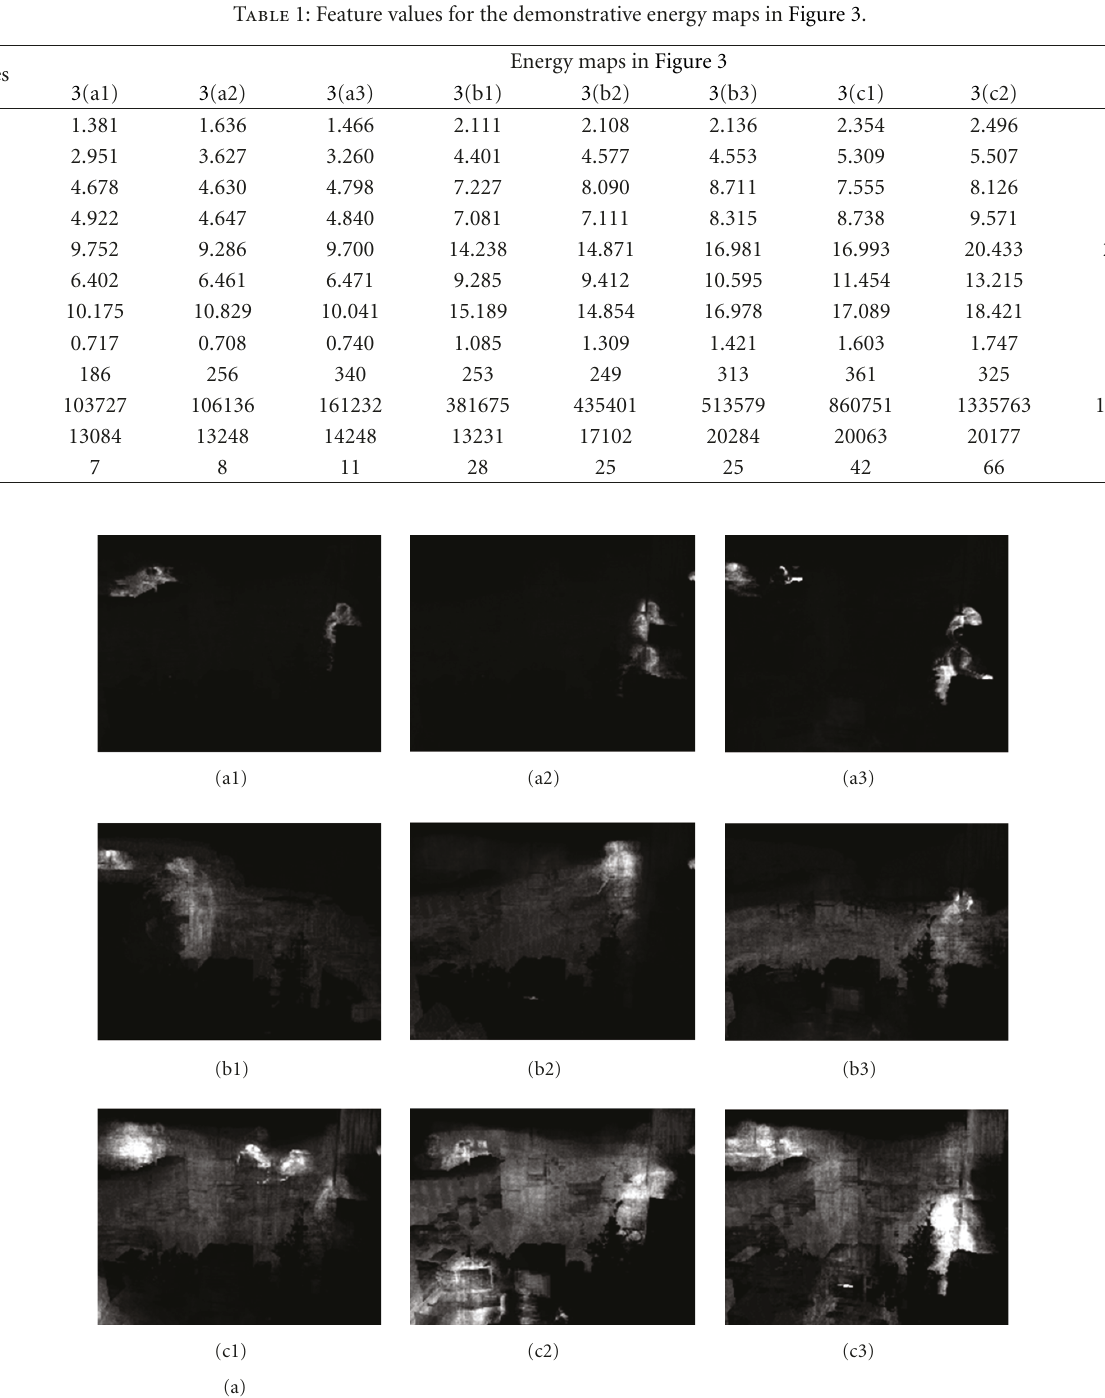
Figure 3: Demonstration examples of energy maps: (a1)–(a3) people sitting in chairs; (b1)–(b3) single person walking in di ff erent directions; (c1)–(c3) interaction between multiple